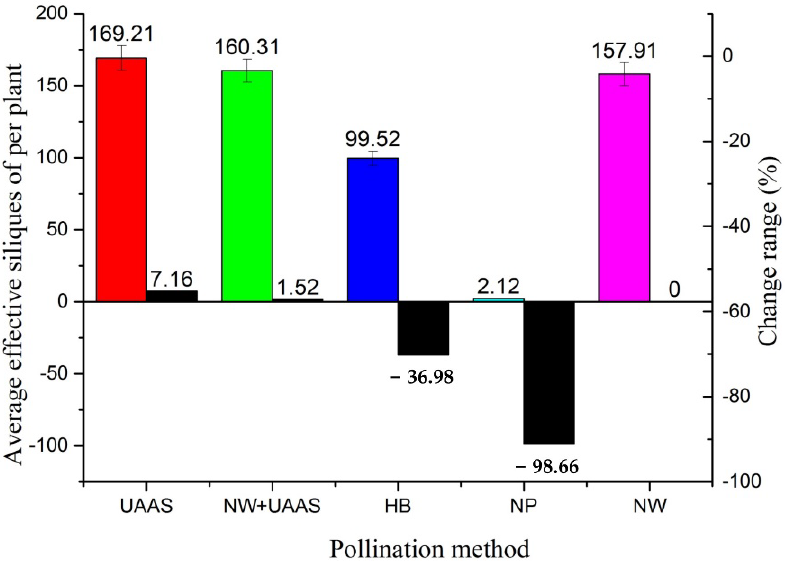
Figure 8. The AESPPs of different pollination areas and AESPP change ranges. Note: UAAS—unmanned agricultural aerial system; NW+UAAS—natural wind + UAAS; HB—honeybee; NP—no pollinators; NW—natural wind; AESPP—average effective siliques per plant.